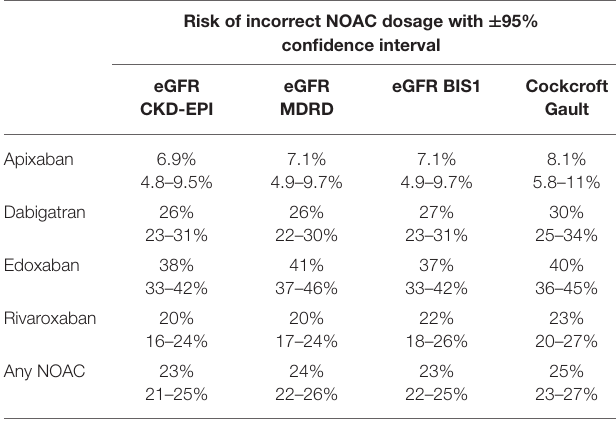
CKD-EPI, Chronic Kidney Disease Epidemiology Collaboration; MDRD, Modification of Diet in Renal Disease Study; BIS1, Berlin Initiative Study; Cockcroft Gault, Cockcroft Gault